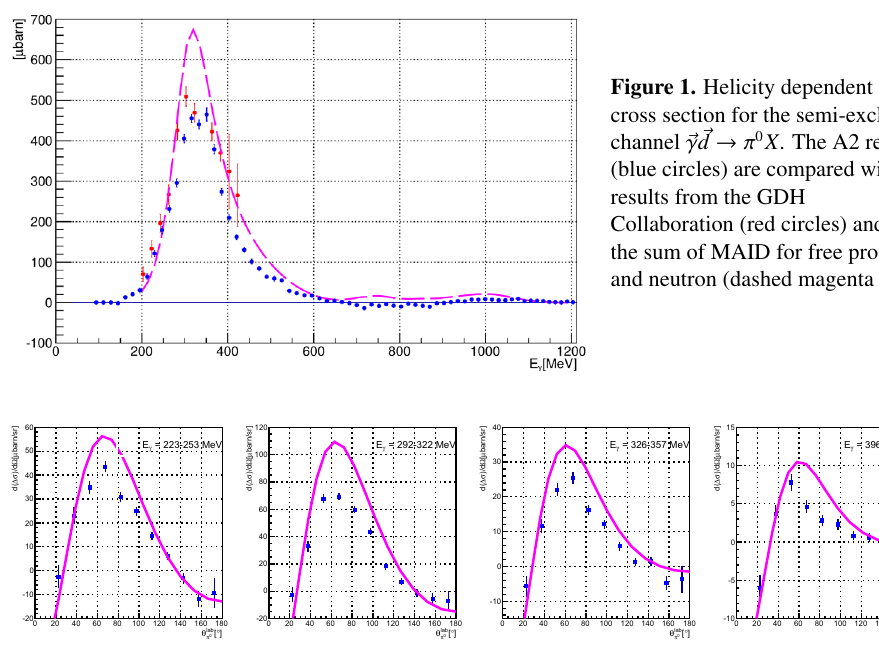
(cid:7)γ(cid:7) d → π 0 X . The